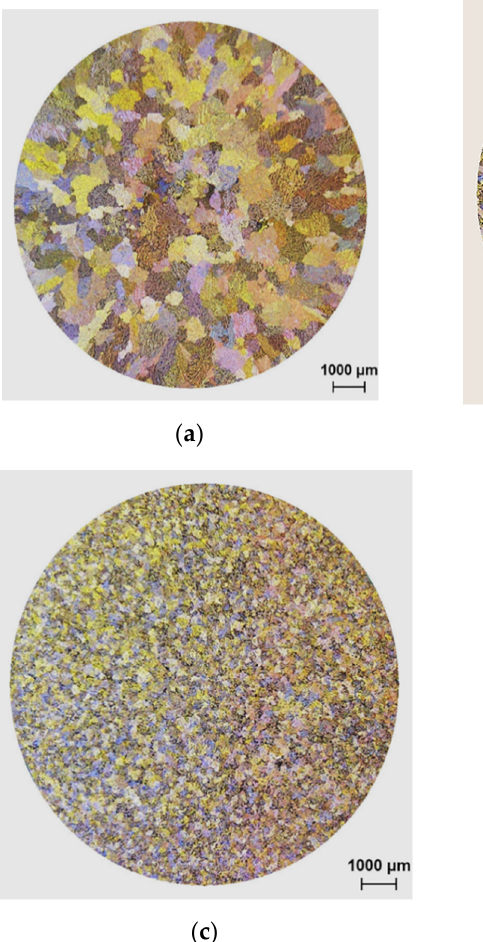
Figure 4. Optical macrostructures showing the grain size in experimental Al-Cu alloy with: ( a ) no Zr, ( b ) 0.3 wt% Zr, and ( c ) 0.15 wt% Ti.